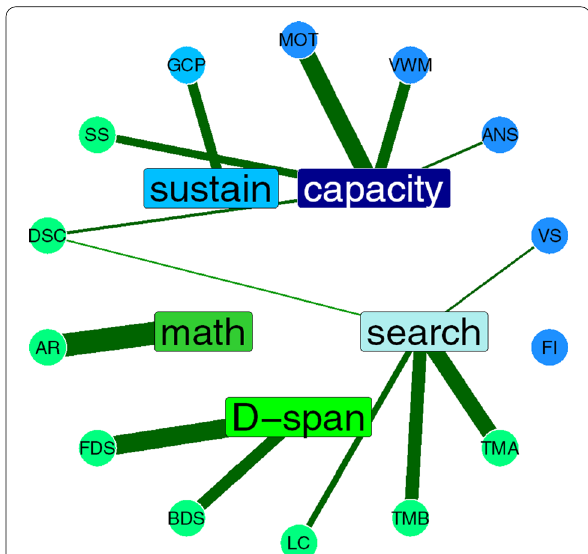
Fig. 5 Graphic depiction of five-factor exploratory factor analysis structure. Tests are disks on the outer circle, factors rectangles on the inner circle. Thickness of lines indicates factor loadings, green for positive, red for negative. Darker blue tests were cognitive paradigms predicted to load onto the a factor. The light blue test (GCP) was predicted to load onto sustained attention factor. Neuropsychological tests are depicted in green